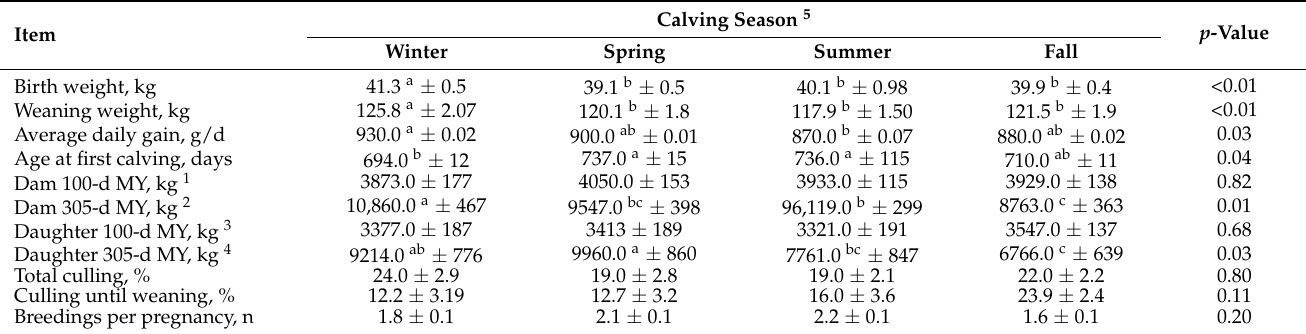
Table 2. Effect of the calving season on the performance of cows and their offspring.